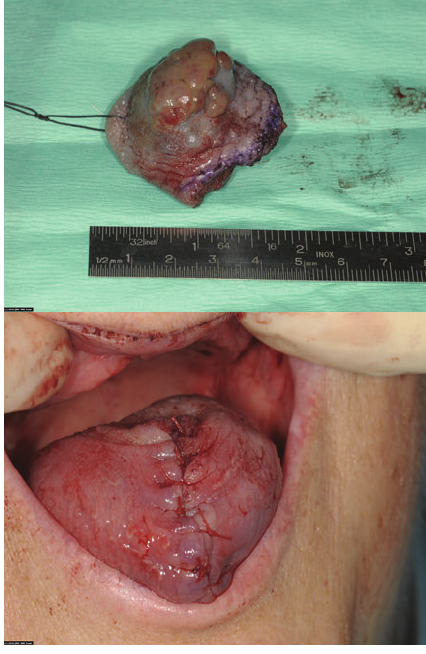
Figure 3: Local surgical